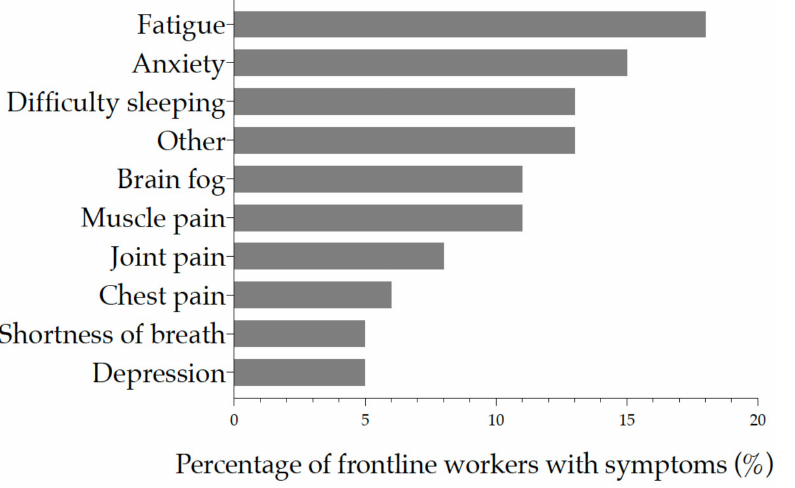
Figure 6. Post-acute COVID-19 symptoms were reported on the day of the survey ( n = 62). Each symptom is ordered from top to bottom by increasing frequency of occurrence. The x-axis represents the proportion of workers with